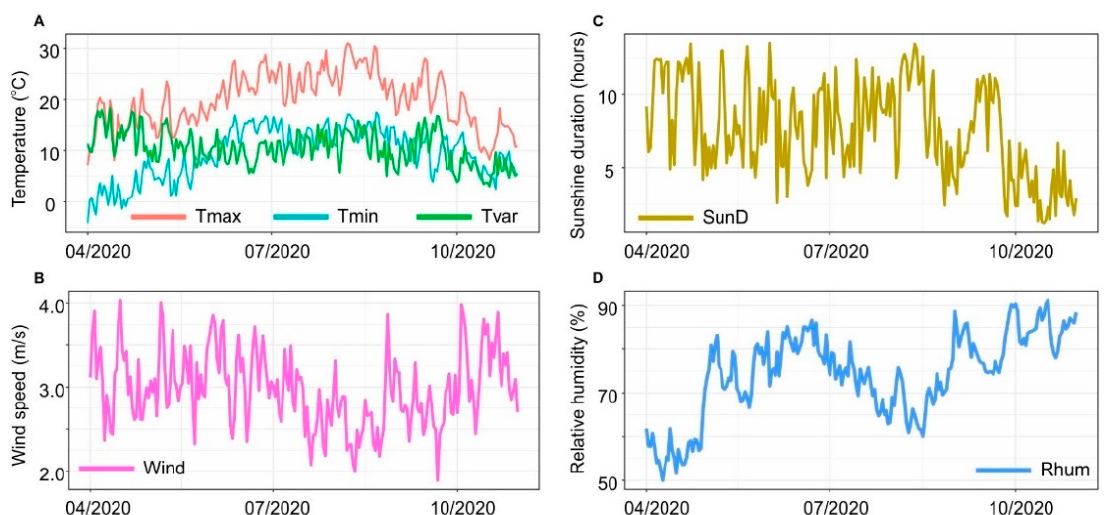
Figure 3. Daily values of maximum temperature (Tmax) ( A —in red), minimum temperature (Tmin) ( A —in blue), variability of mean daily temperature (Tvar) ( A —in green), sunshine duration (SunD) ( C ), wind speed (Wind) ( B ), relative humidity (Rhum) ( D ) for Poland.